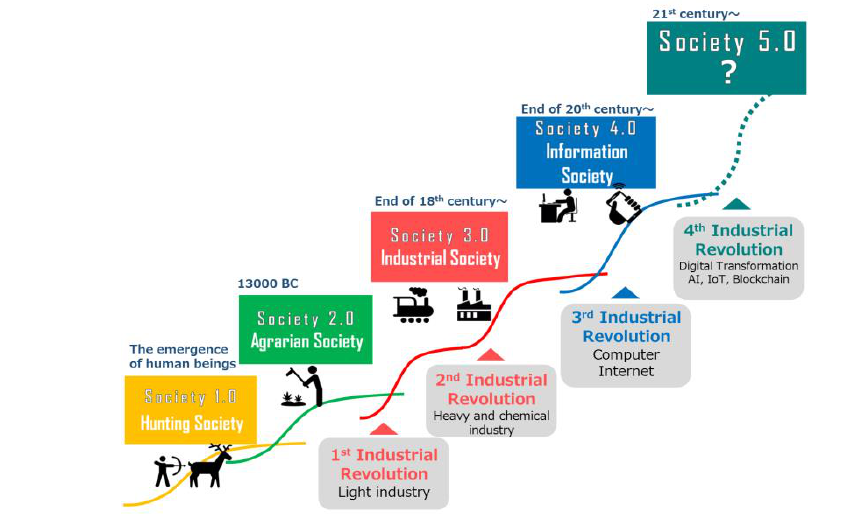
Source: Keidanren